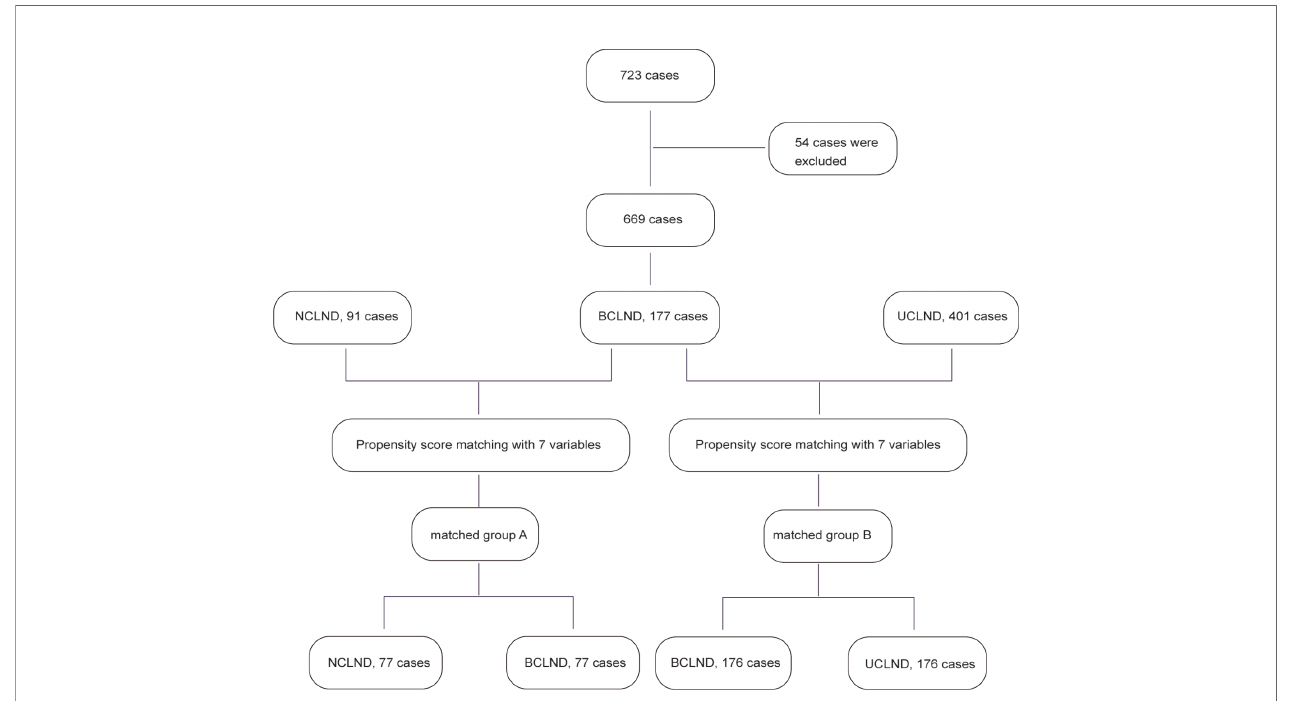
FIGURE 1 | Flowchart of patients with isthmic papillary thyroid cancer in this